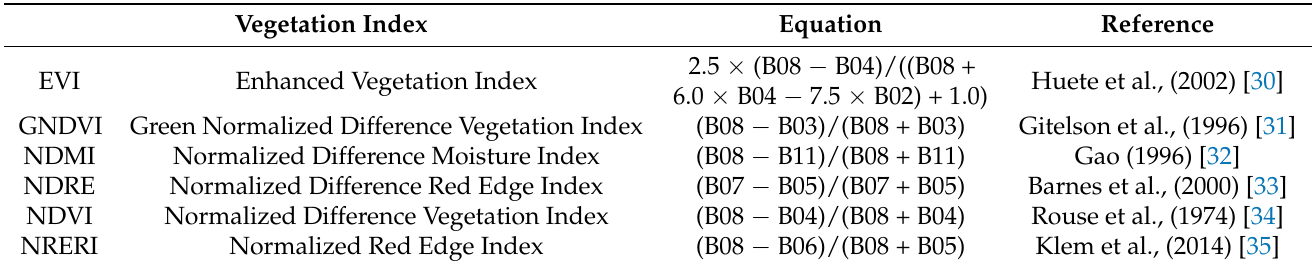
Table 2. Sentinel-2 vegetation indices evaluated in the